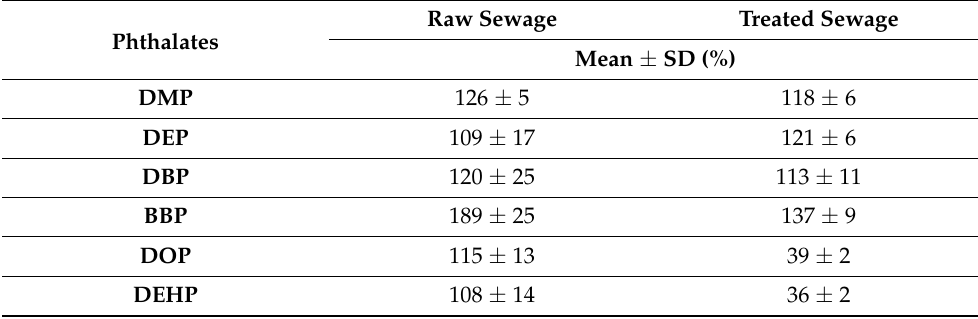
Table 1. Absolute recovery (mean ± SD, %) of the target PAEs from wastewater samples spiked with the target phthalates to the concentrations: 250 ng × L −1 , 500 ng × L −1 and 1000 ng × L −1 , using Oasis HLB (n = 3).